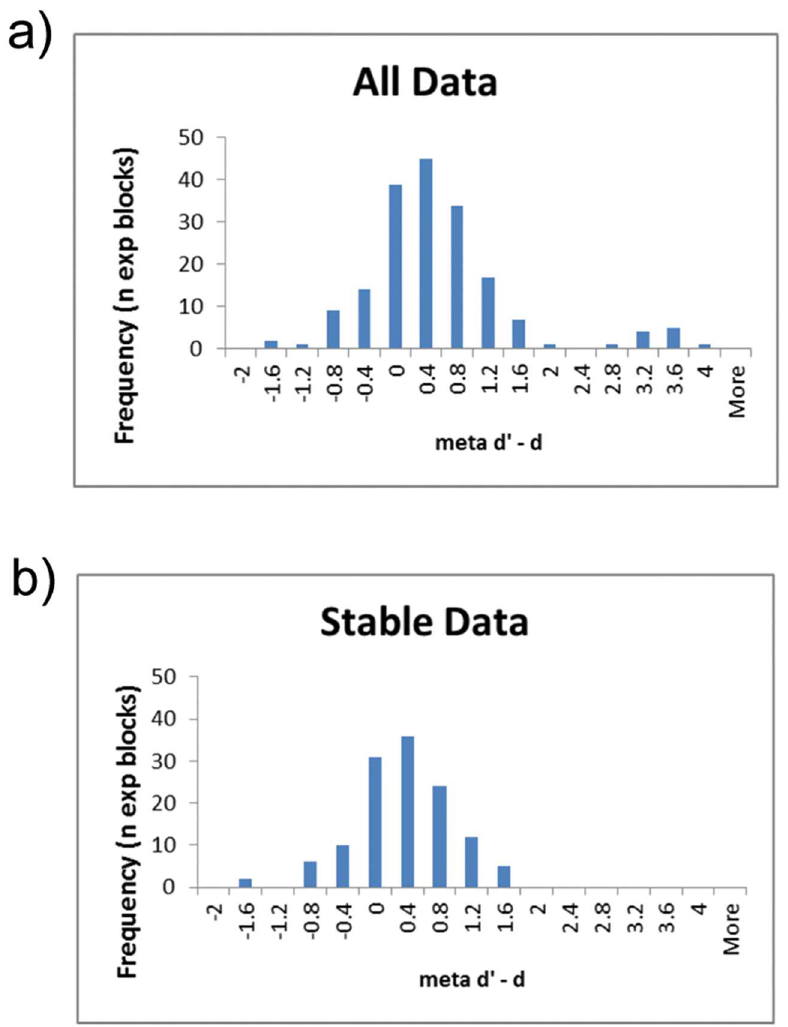
Fig 4. Histogram of distribution of meta d’—d’ values. Histograms, using 0.4 sized bins, of meta d’—d’ for a) stable data only, per subject experimental block; and b) all data (includingunstable). Whereas the stable data is Gaussian, the unstable data is